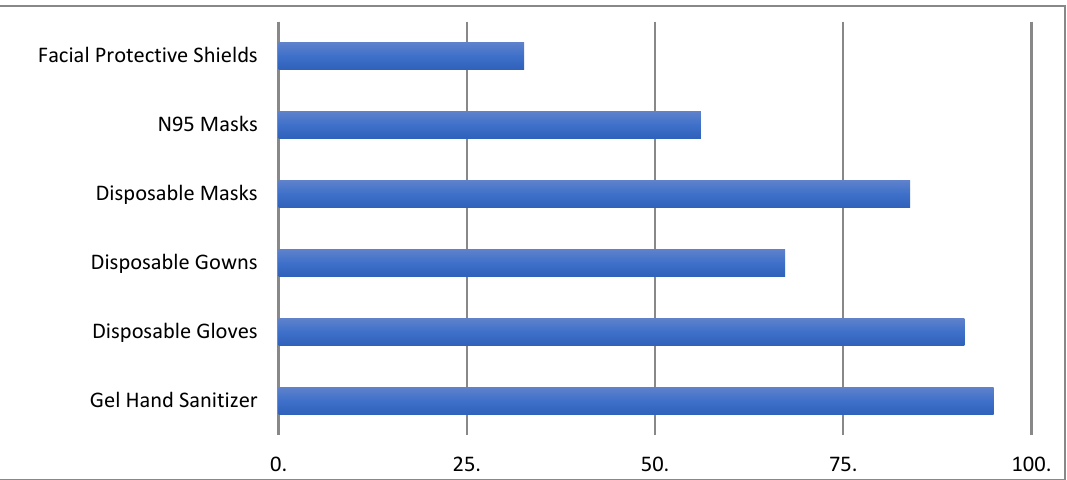
Figure 1. Distribution of participants by geography location.